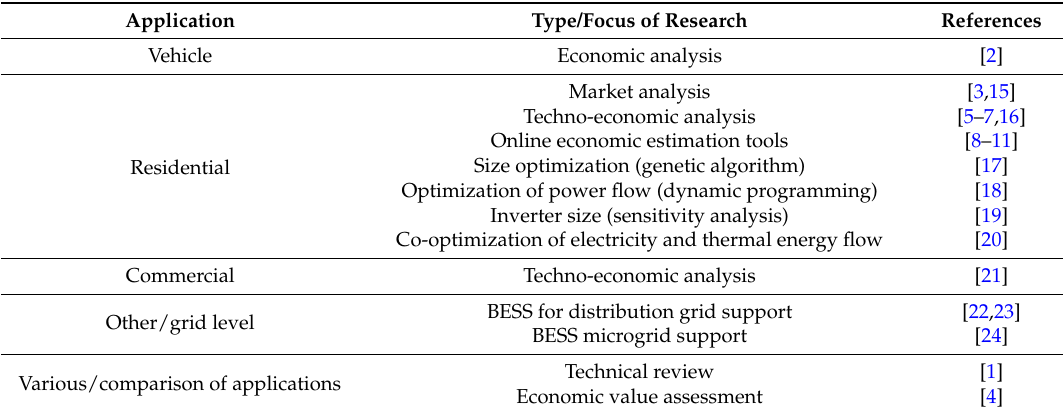
Table 1. Non-comprehensive overview of literature in the field of battery energy storage system (BESS) analysis and